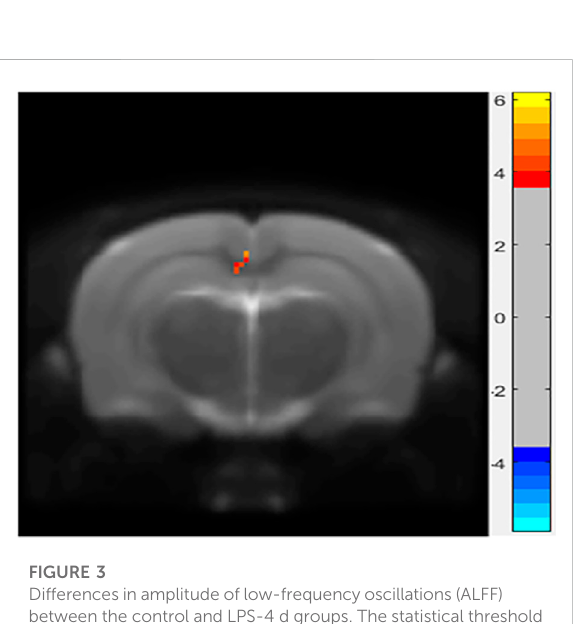
FIGURE 3 Differences in amplitude of low-frequency oscillations (ALFF) between the control and LPS-4 d groups. The statistical threshold was set at cluster size > 6, which corresponds to a corrected p <